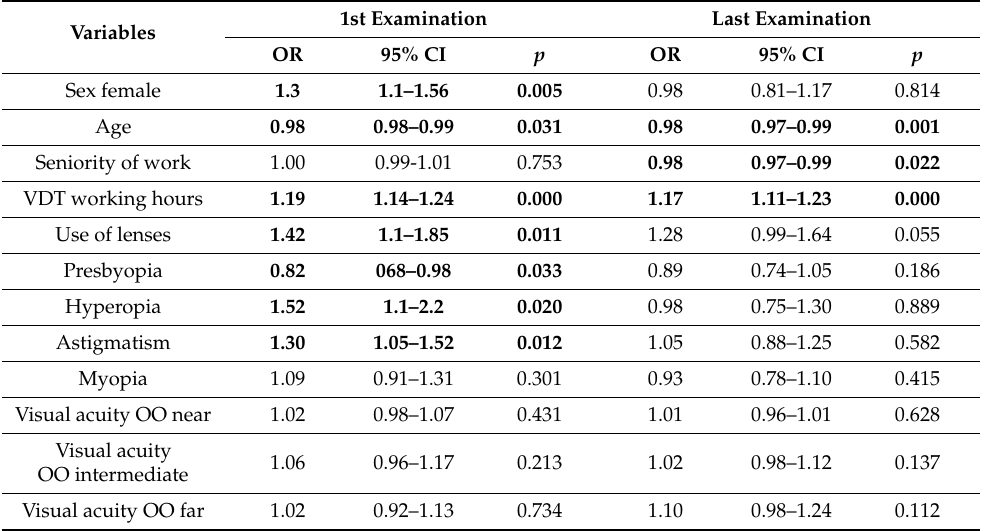
Table 4. Visual fatigue, visual acuity and refractive disorders in the first and in the last control evaluated with univariate logistic regression. Data are reported as odds ratios (OR) and 95% confidence intervals (CI).